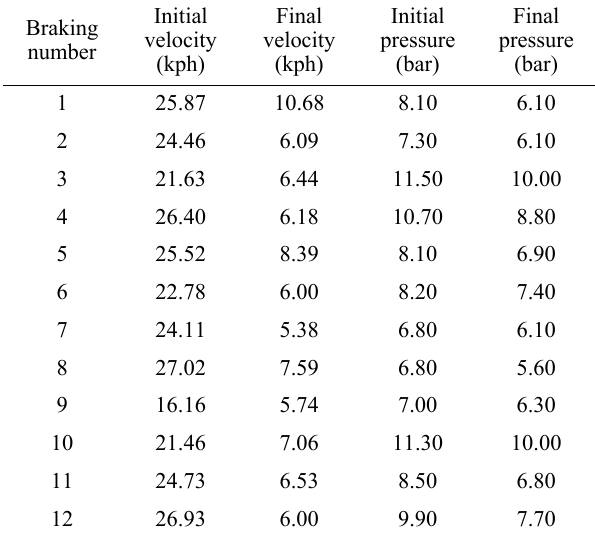
Table 2 Brake events: Vehicle velocity and brake system pressure.